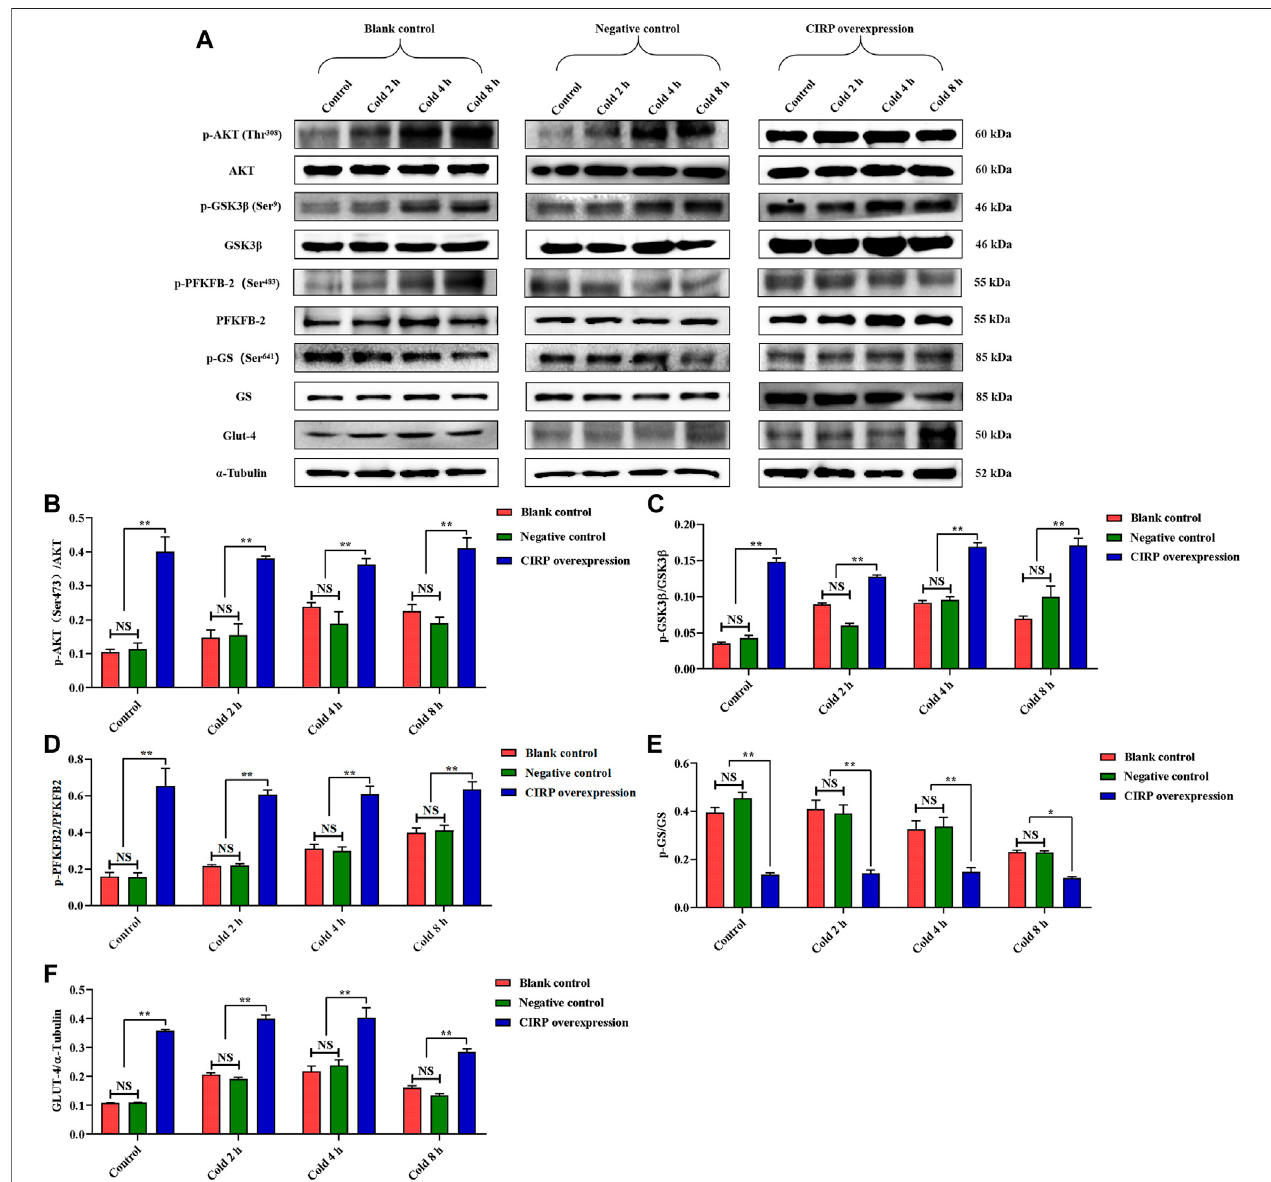
FIGURE5| Effects ofmild hypothermia and CIRP overexpressionon AKT anddownstreamglucosemetabolismpathways. (A) Westernblottingresults ofglucose metabolism related proteins in each group. The protein expression levels and phosphorylation status of AKT (B) , GSK3 β (C) , PFKFB2 (D) , GS (E) and GLUT-4 (F) in C2C12 cells. The data are presented as the mean ± SEM (n (cid:1) 8). Statistically signi fi cant differences are indicated; * p < 0.05, ** p < 0.01. AKT, protein kinase B; GSK3 β , glycogen synthase kinase-3 β ; PFKFB2, 6-phosphofructo-2-kinase/fructose-2,6-biphosphatase 2; GS, glycogen synthase; GLUT-4, glucose transporter-4.